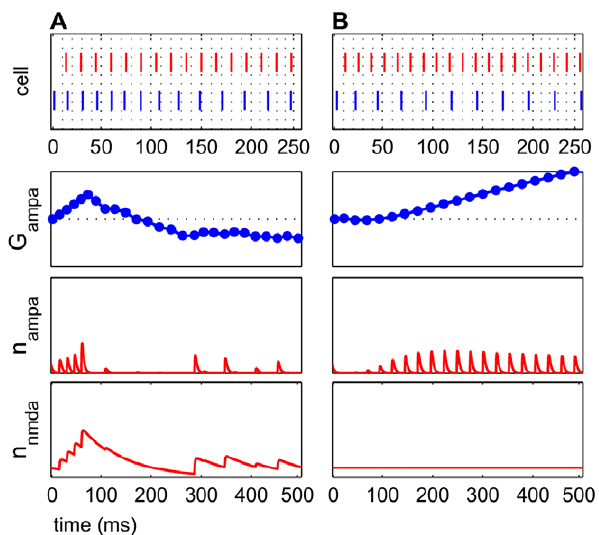
Figure 9. Greater coherence increases potentiation. The top panel in each subfigure shows a raster plot with spikes from each of 3 inputs (red, green, and purple) and spikes from the E cell (blue). The input spikes are randomly distributed with a variance of (1 { C ) about the mean ISI. The time axis is enlarged to show detail. Second panels are total AMPAR conductance. Third panels are AMPAR conductance for each synapse for each individual input, rescaled. Bottom panels are NMDAR current open probabilities n nmda for each input. (A) C=0.99 resulted in prolonged potentiation for this simulation with 3 inputs. (B) C=0.10 resulted in diminished, brief potentiation, since input ISIs were still in a potentiating regime but not coherent.